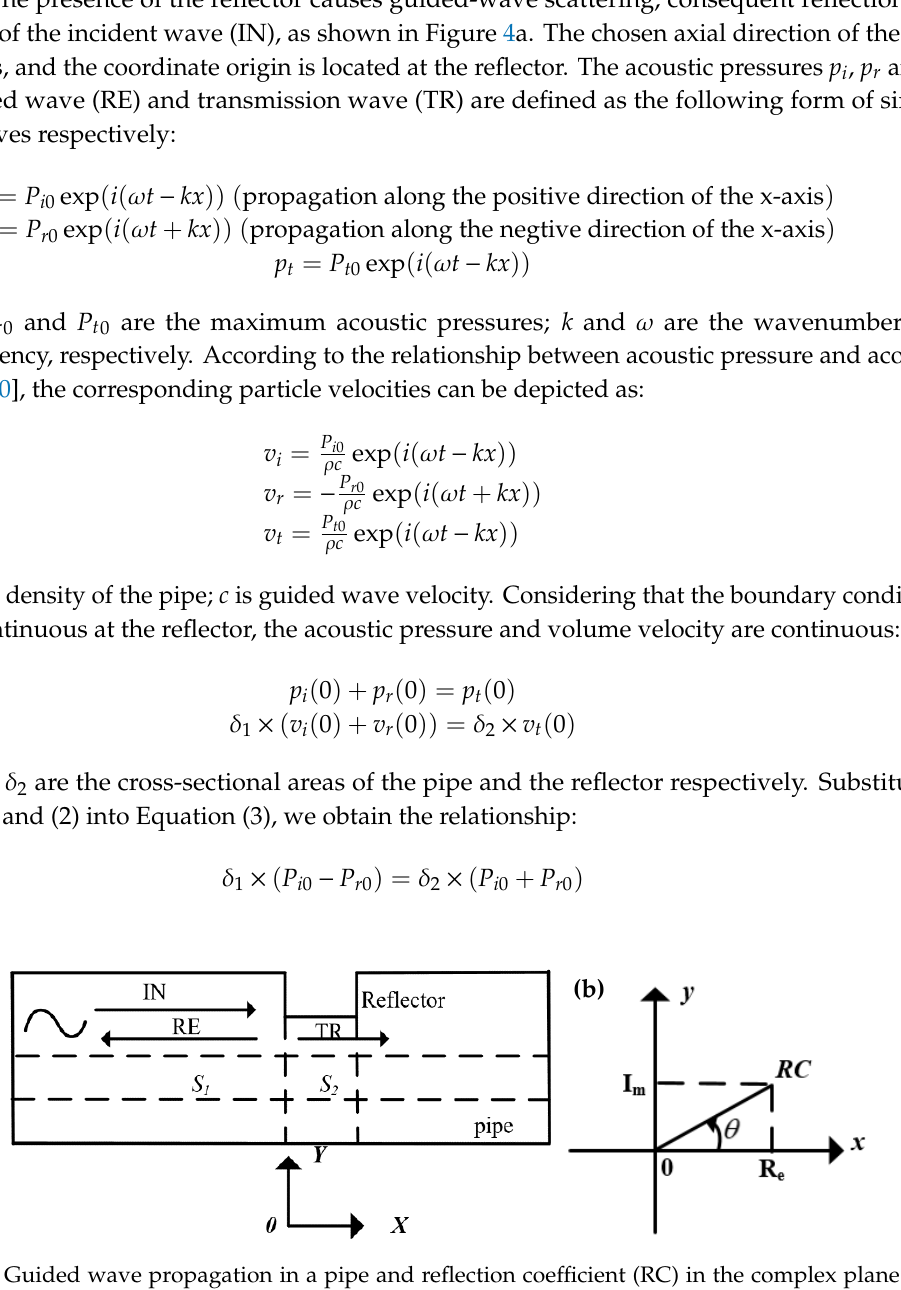
Figure 5. A reflector can be decomposed into a step down and a step up .